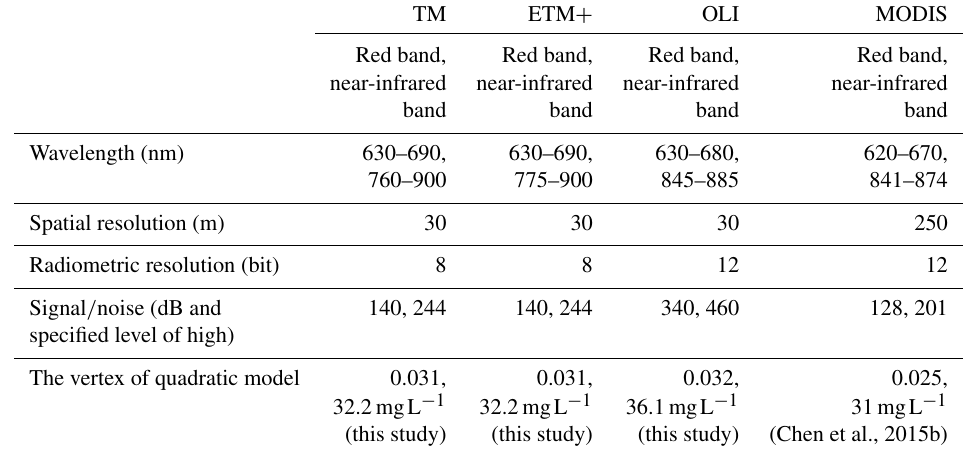
Table 4. The performance of different sensors and the vertices of QRLTSS model based on these sensors.